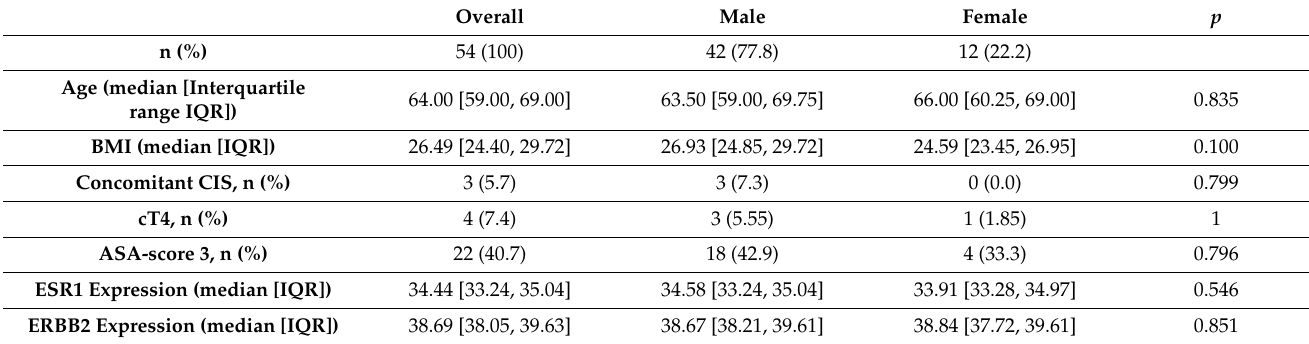
Table 1. Patient characteristics according to gender neoadjuvant chemotherapy (NAC) ( n =